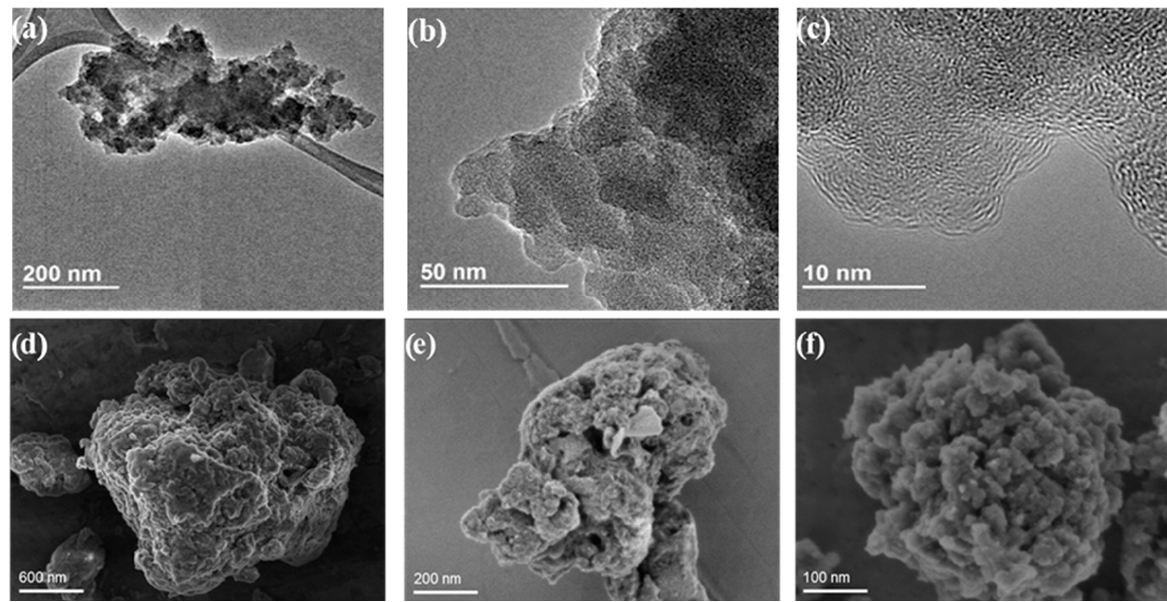
Figure 2. TEM images and EDX of: COP–3 before ( a ) and after ( b ) Pd NPs removal.